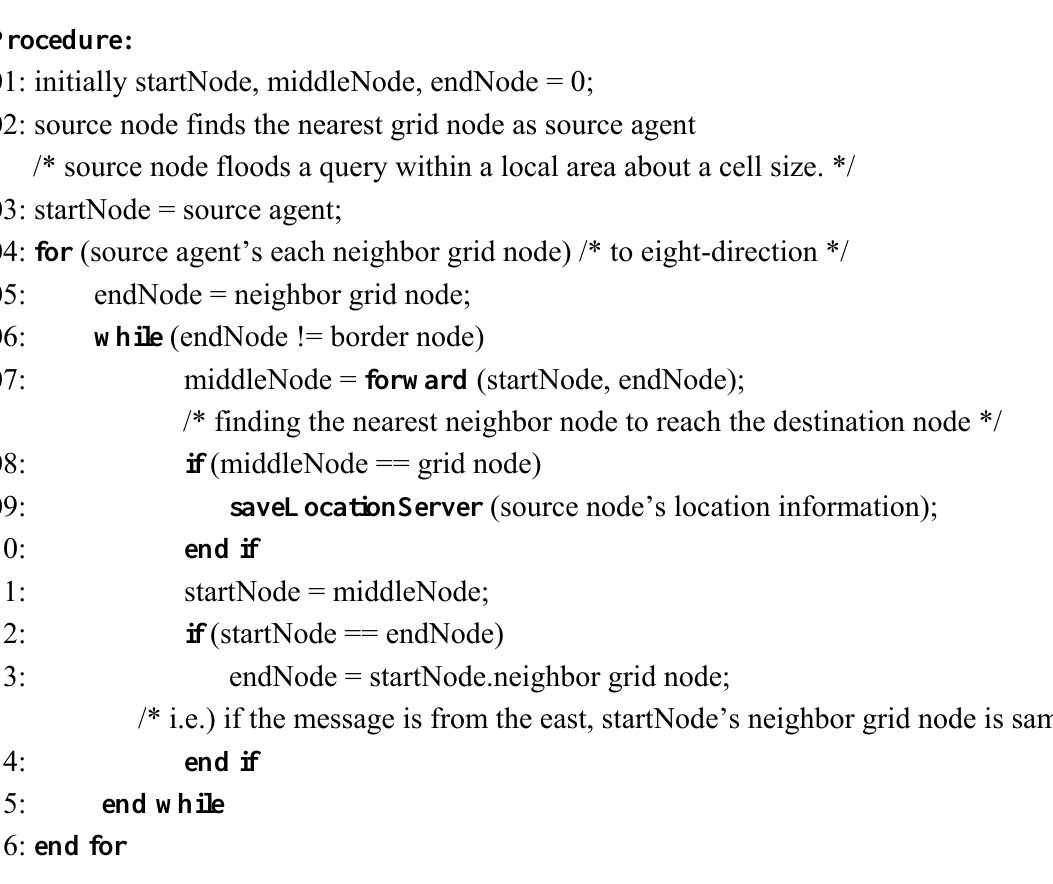
Algorithm 1. Pseudo-code to make an Eight-Direction Anchor system at source